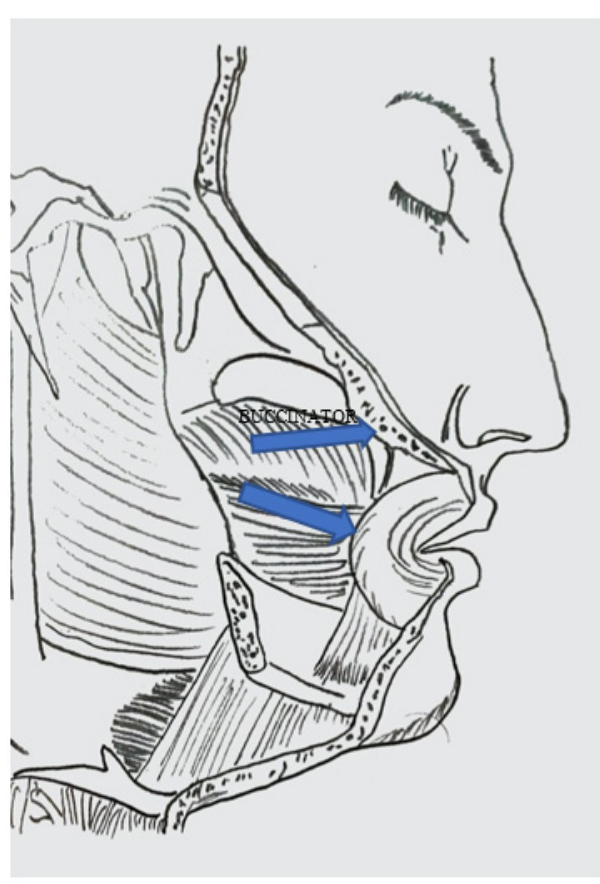
Figure A1. Buccinator flap two bundle.